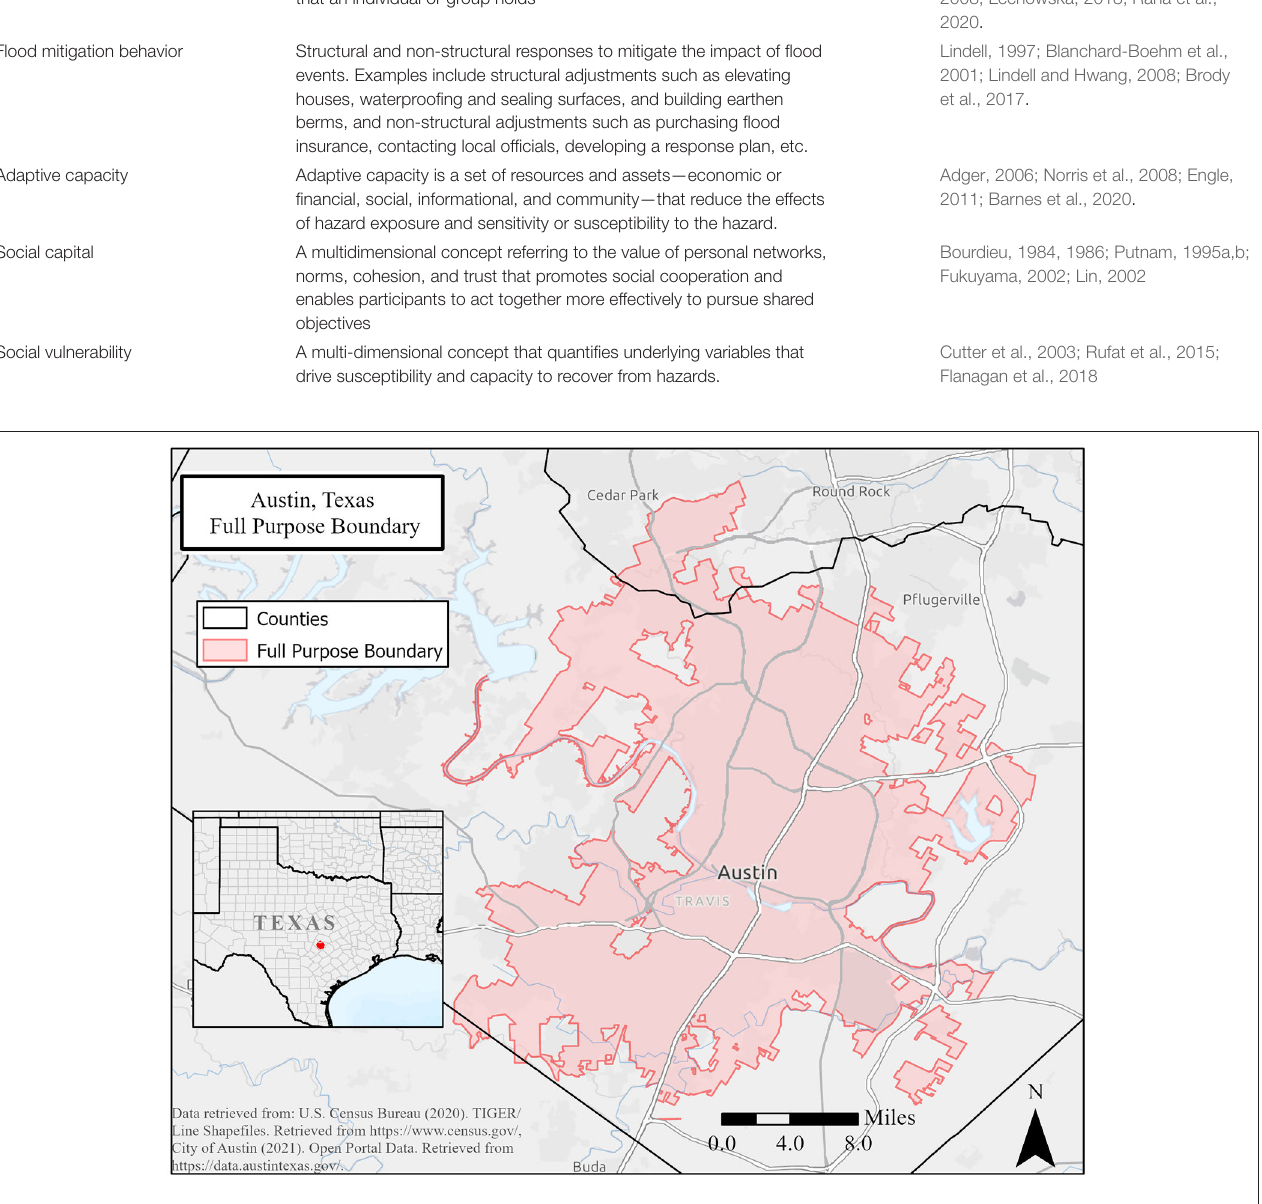
FIGURE 1 | Study area- Austin, Texas,